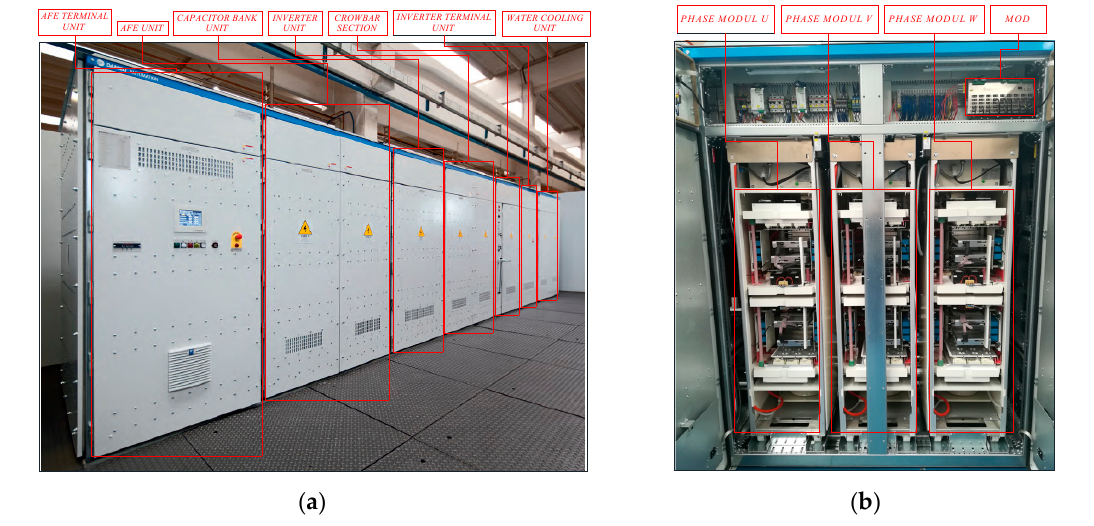
Figure 8. ( a ) MV drive cabinet layout; ( b ) IGCT based 3L-NPC unit.